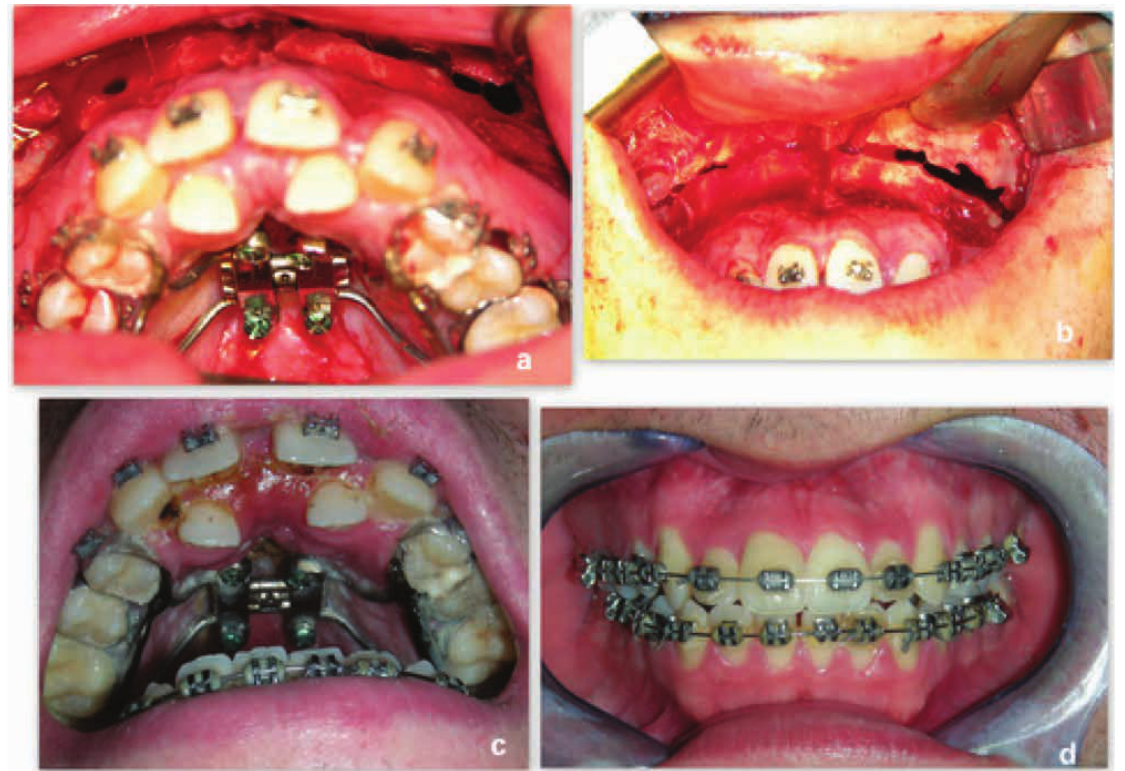
Figure 2: Case 2 of the upper jaw surgery (table 2) showing Le-Fort I modified osteotomy line conducted under the anterior nasal spine leaving attached the perinasal muscle; a) intra operative view with inserted distractor device in a paramedian site; b) modified Le Fort I osteotomy line conducted beneath the anterior nasal spine; c) intraoral view during active distraction time; d) post operative